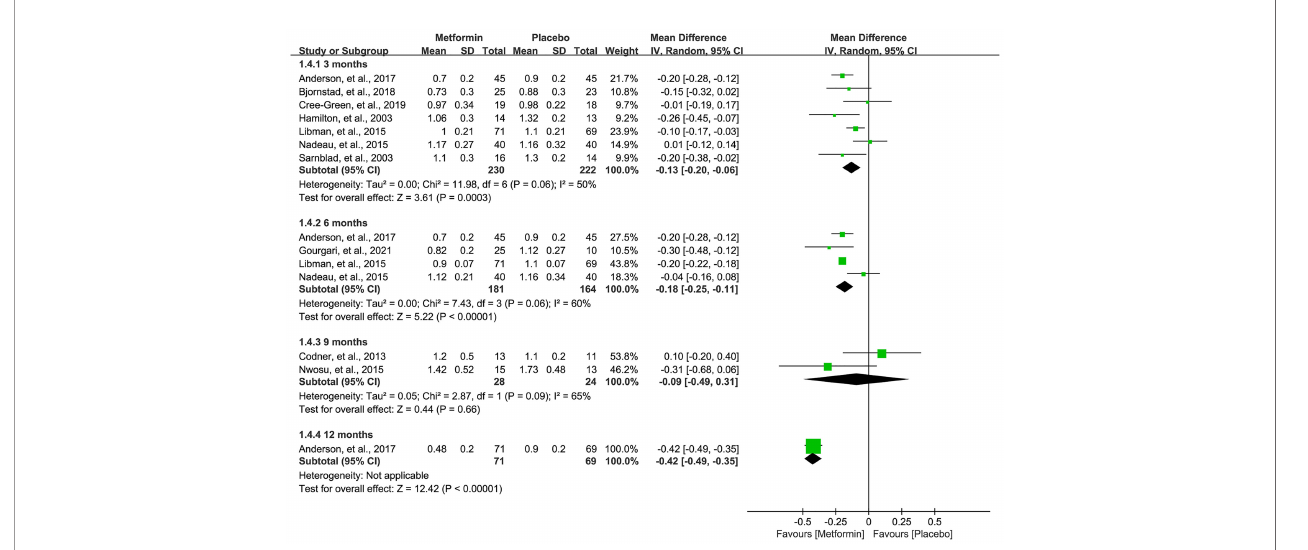
FIGURE 5 | Forest plot of the comparative ef fi cacy between metformin and placebo in terms of total insulin daily dose at different follow-up duration.